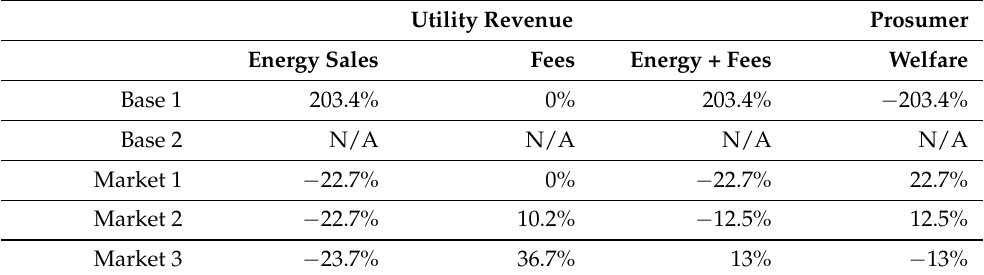
Table 3. Revenue Streams for the different scenarios and stakeholders. The differences are in regards to the Base 2